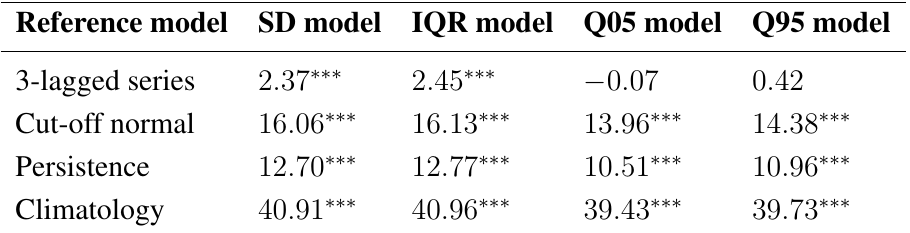
Table 12. Out-of-sample Average Skill CRPS ( % ) (also averaged over all wind farms) for the averaged over 24-steps CFS optimized models. The asterisks indicate the statistical significance of the gain/loss according to the Amisano and Giacomini test with the following significance codes for the p -value of the test: ***: p ≤ 0 . 01 , **: 0 . 01 < p ≤ 0 . 05 , *: 0 . 05 < p ≤ 0 . 1